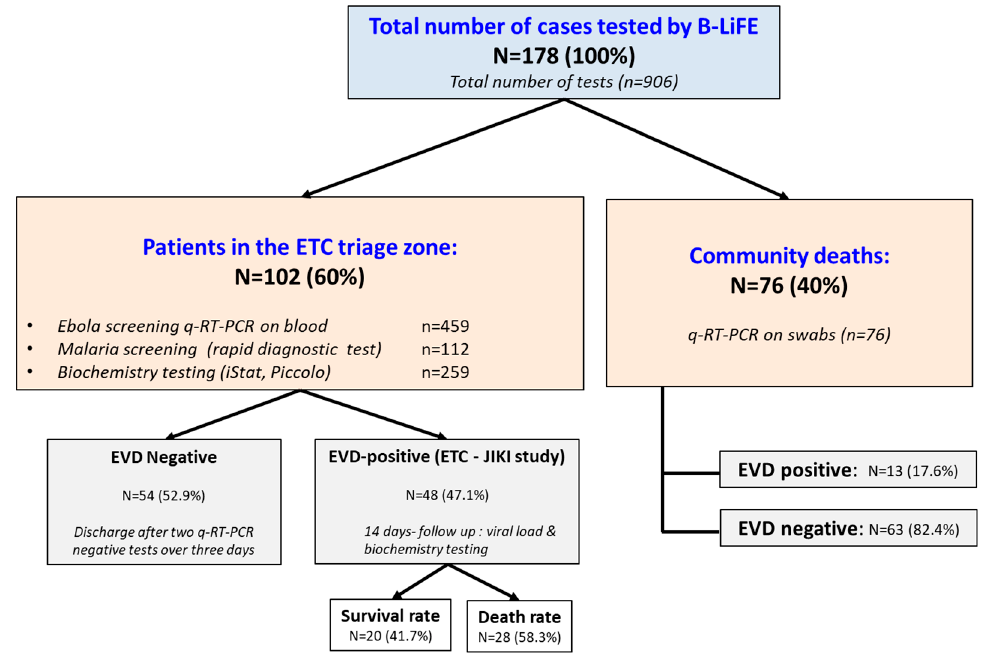
Figure 5. A breakdown by EVD status of the total cases and samples analysed during the B-LiFE Ebola mission in Guinea.